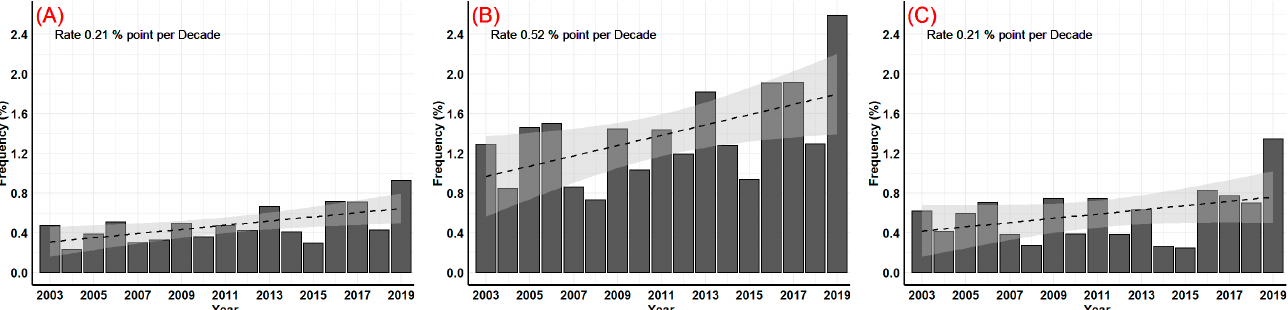
Figure 6. Frequency of annual hourly precipitation (percentage of wet hours) estimated by ( A ) CMORPH, ( B ) IMERG, and ( C ) PERSIANN.